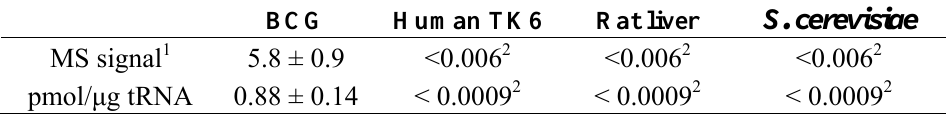
Table 2. Level of m 6 A in tRNA from BCG, human, rat and 2